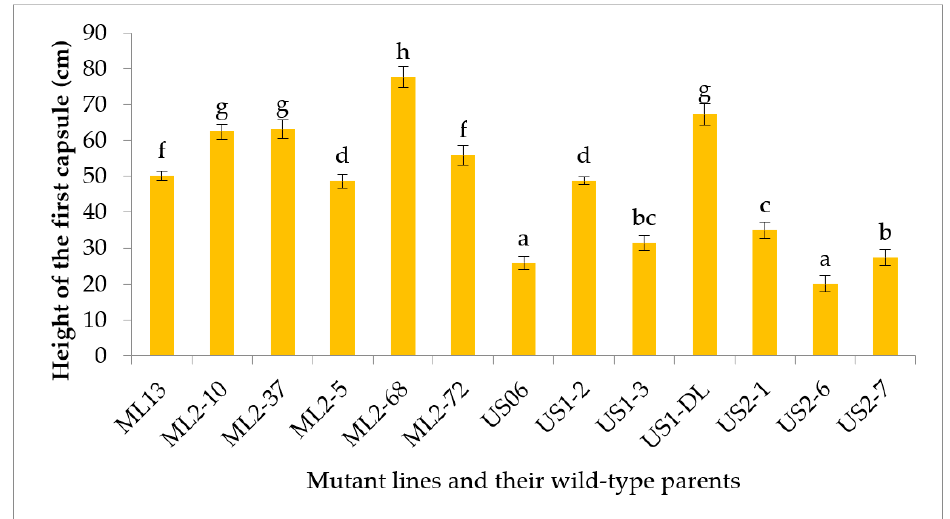
Figure 3. Height of the first capsule (HFC) in 11 sesame mutant lines and their two wildtypes (US06 and ML13). The superscript letters represent the groups according to Duncan’s test.